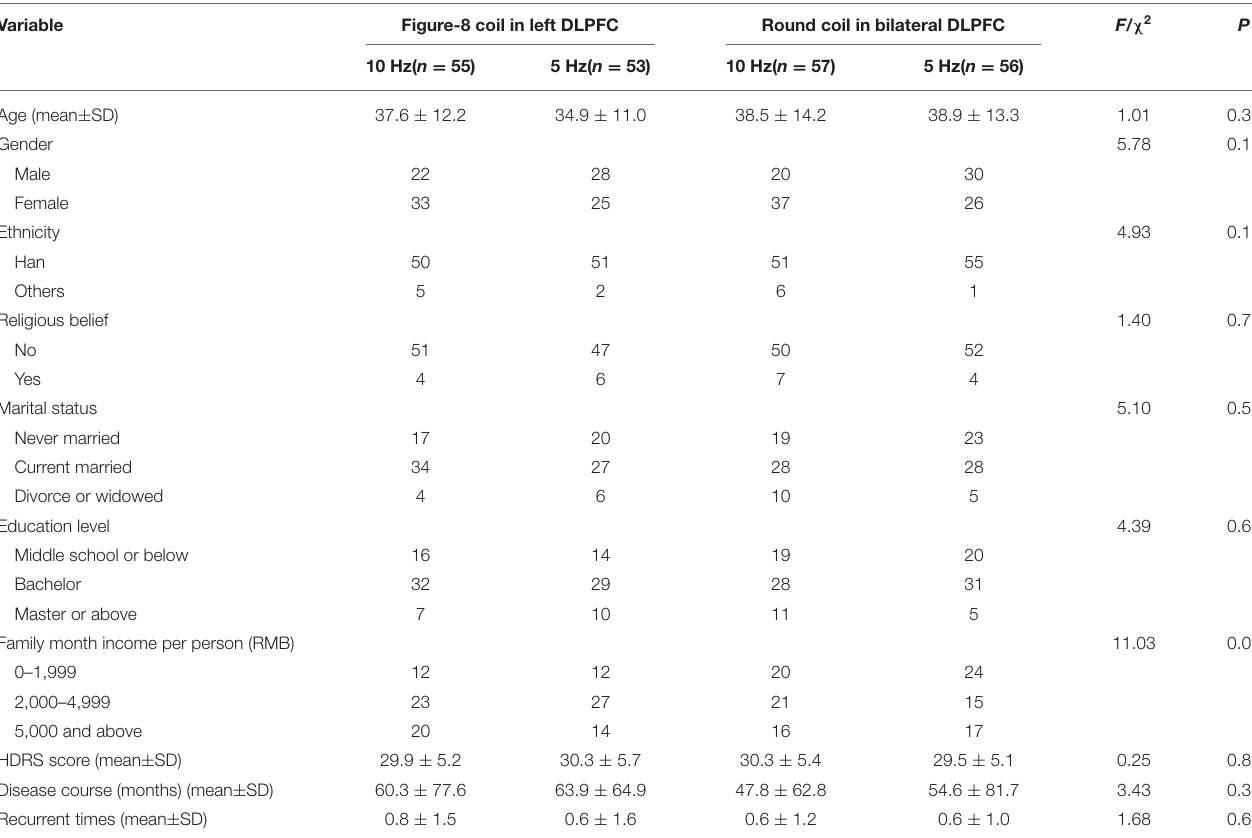
TABLE 1 | Socio-demographic and clinical characteristics of the sample ( N = 221). Variable Figure-8 coil in left DLPFC